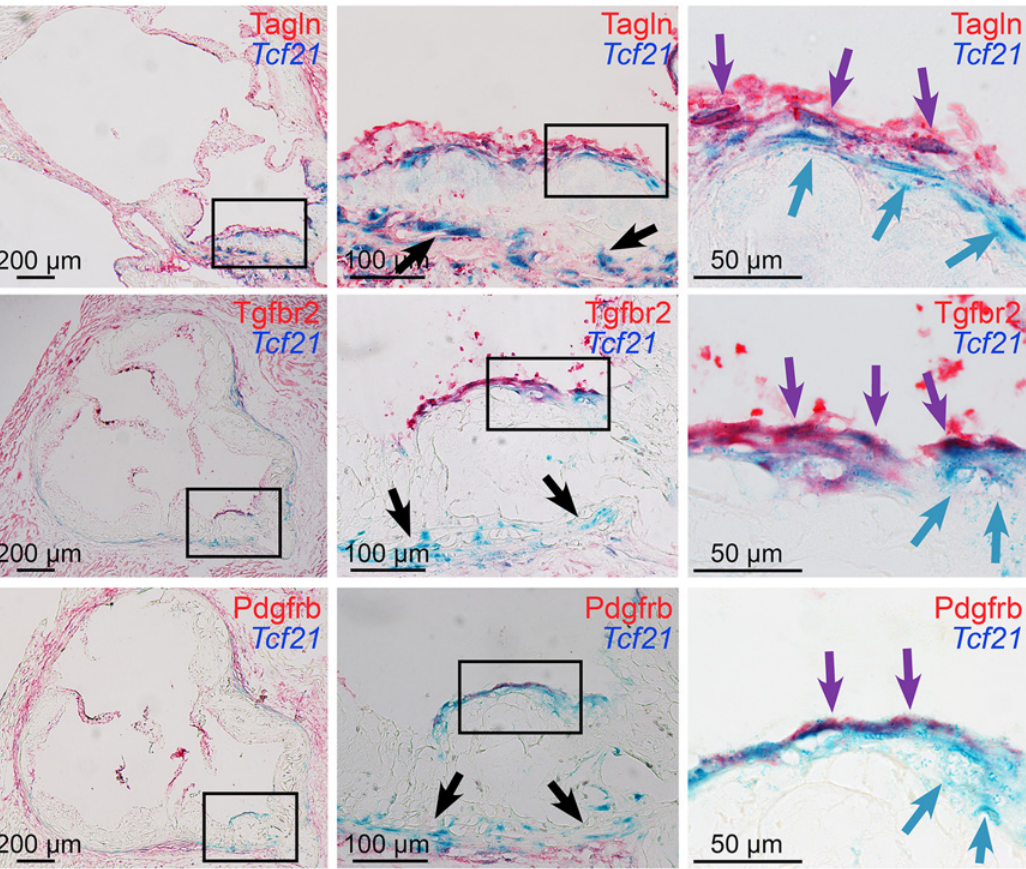
Fig 4. Tcf21 expressing cells associate with the fibrous cap. Xgal stained lesions in Tcf21 lacZ/+ , ApoE -/- mice fed HFD for 20 weeks were evaluated by immunohistochemistry for expression of fibrous cap markers. Tcf21 reporter expressing cells (blue indicator) were identified in the media and adventitia (black arrows, middle panels), and in association with the fibrous cap (blue arrows, right panels). β -galactosidase negative cells in the luminal aspect of the fibrous cap stained positive for Tagln, as well as growth factor receptors Tgfbr2 and Pdgfrb (red indicator). In addition, in the region of the fibrous cap, cells were identified that showed staining for Tcf21 expression as well as Tagln and growth factor receptors (purple arrows).